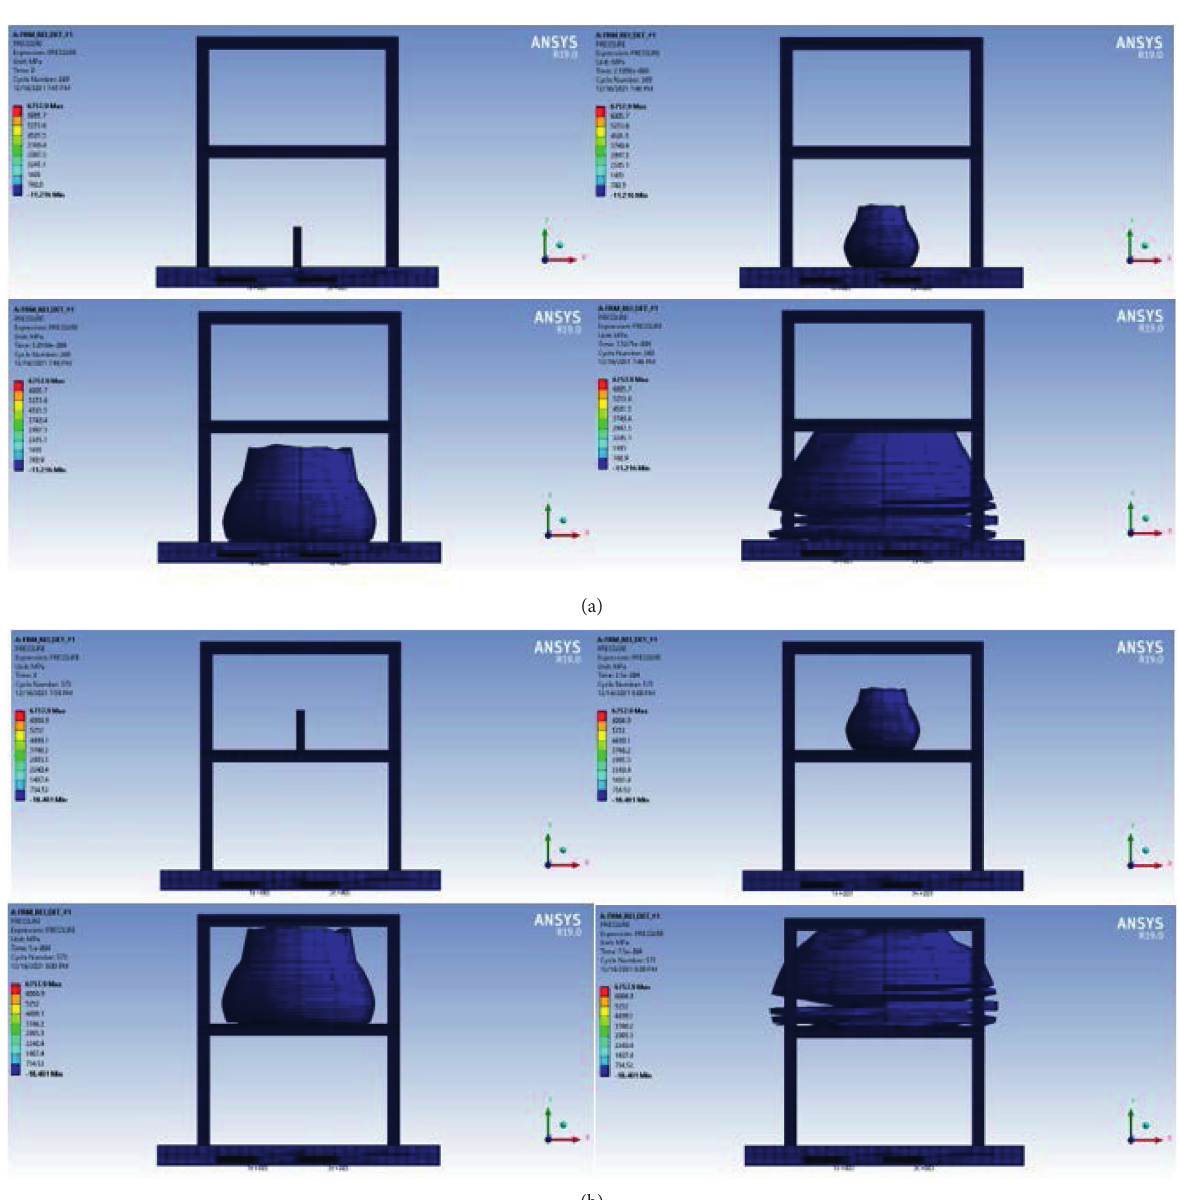
Figure 18: Blast pressure wave propagation time for two blast